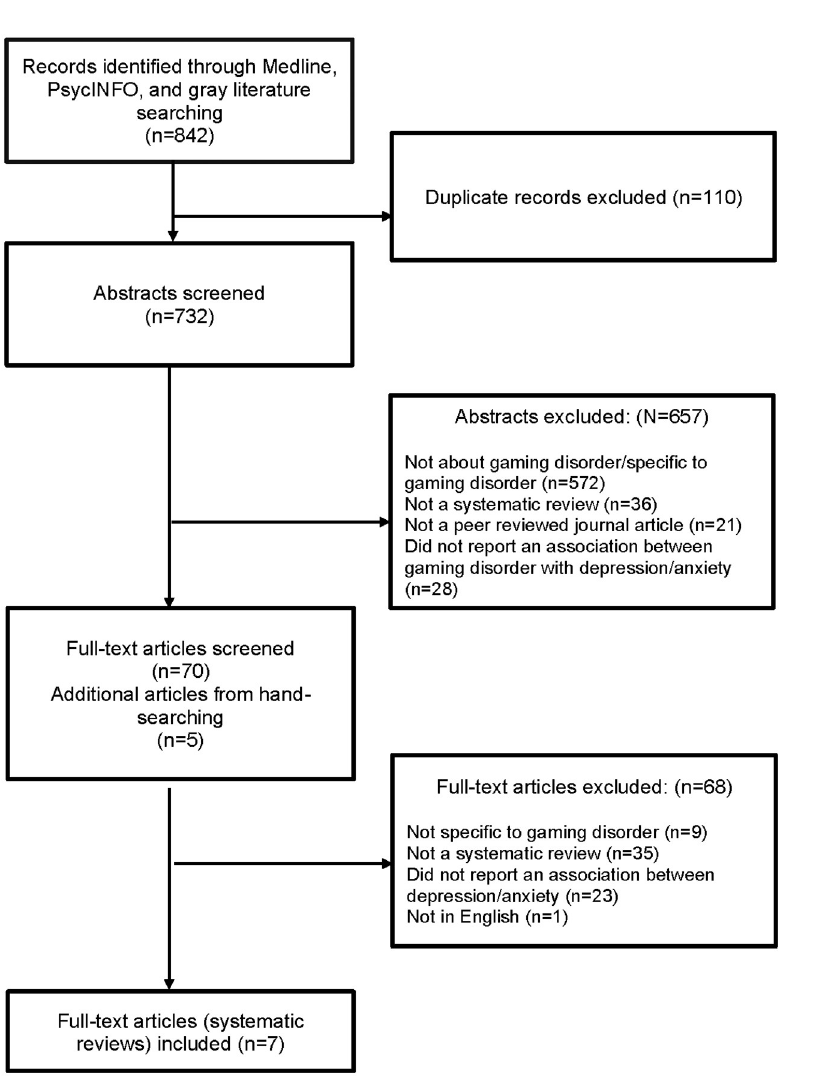
Fig 4. PRISMA flow